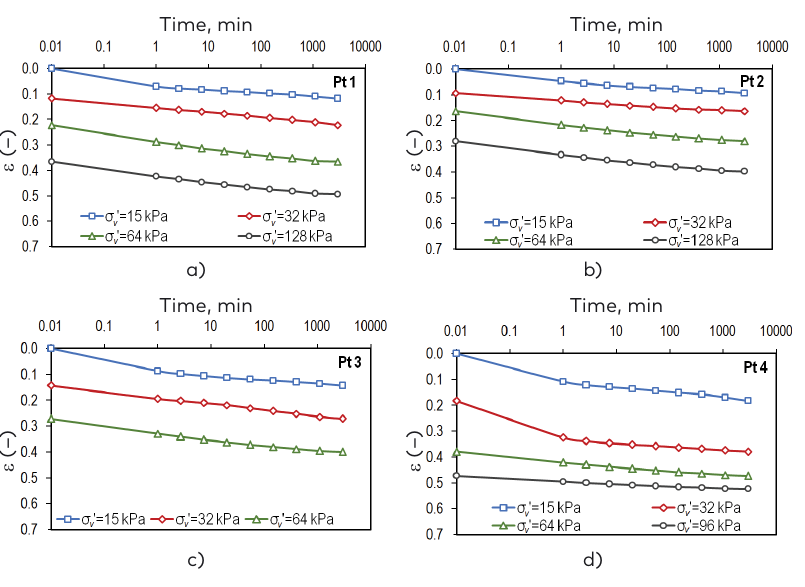
Figure 4. Strain versus time curves for the tested peat: a) Pt 1; b) Pt 2; c) Pt 3; d) Pt